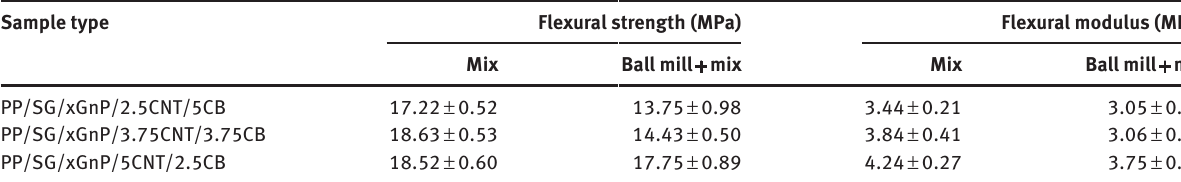
Table 5: The flexural properties of the PP/SG/xGnP combined with the MWCNTs and CB. Sample type